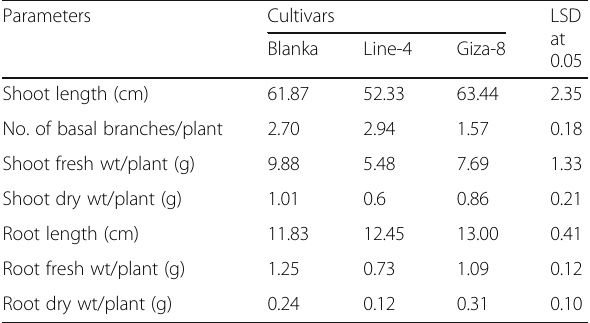
Table 2 Effect of cultivars on growth parameters of flax plants grown under sandy soil conditions (data are means of two seasons)